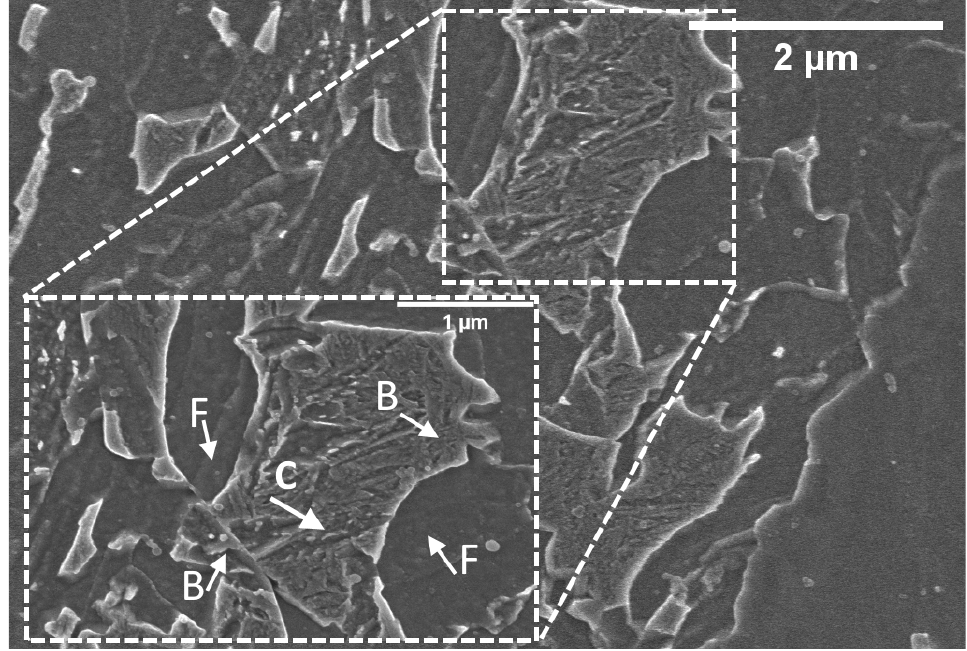
Figure 1. High-resolution micrography showing bainitic islands (indicated as B) surrounded by ferritic matrix (indicated as F). Carbide platelets are indicated with a C.